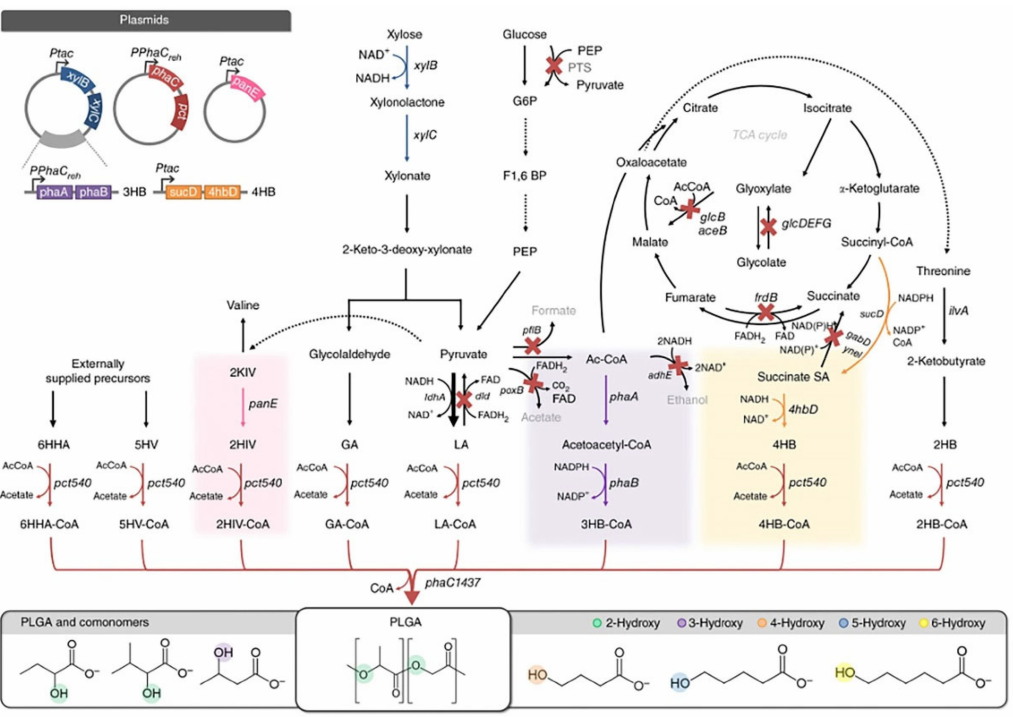
Figure 1. The synthesis of PLGA in Escherichia coli. Black arrows indicate the native pathways in E. coli ; red arrows indicate heterologous pathways for polymerization of various monomers; pink, purple and orange arrows and shading indicate biosynthetic pathways for the generation of 2-hydroxyisovalerate CoA (2HIV-CoA), 3-hydroxybutyrate CoA (3HB-CoA) and 4-hydroxybutyrate CoA (4HB-CoA), respectively; blue arrows indicate the Dahms pathway. X-marks indicate inactivated metabolic pathways; bold arrows indicate metabolic pathways strengthened by replacement of native promoter. Dotted arrows indicate pathways that have been simplified from more than one conversion step. G6P, glucose 6-phosphate; F1,6BP, fructose-1,6-bisphosphate; PEP, phosphoenolpyruvate; Succinate SA, succinate semialdehyde; Ac-CoA, acetyl-CoA; LA, D-lactate; GA, glycolate; 2KIV, 2-ketoisovalerate [17]. Copyright 2016, Springer